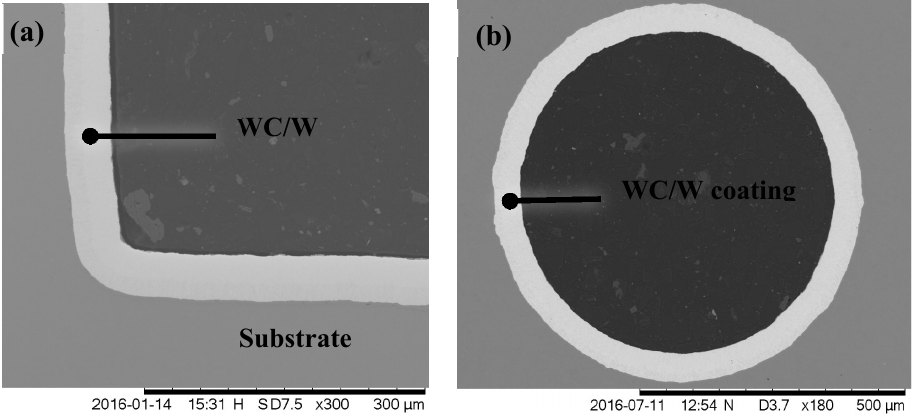
Figure 6. Cross-sectional SEM images of WC/W coating deposited through chemical vapour deposition (CVD) on ( a ) internal corner and ( b ) inside a 0.5 mm hole. Copyright of Hardide Coatings Plc.